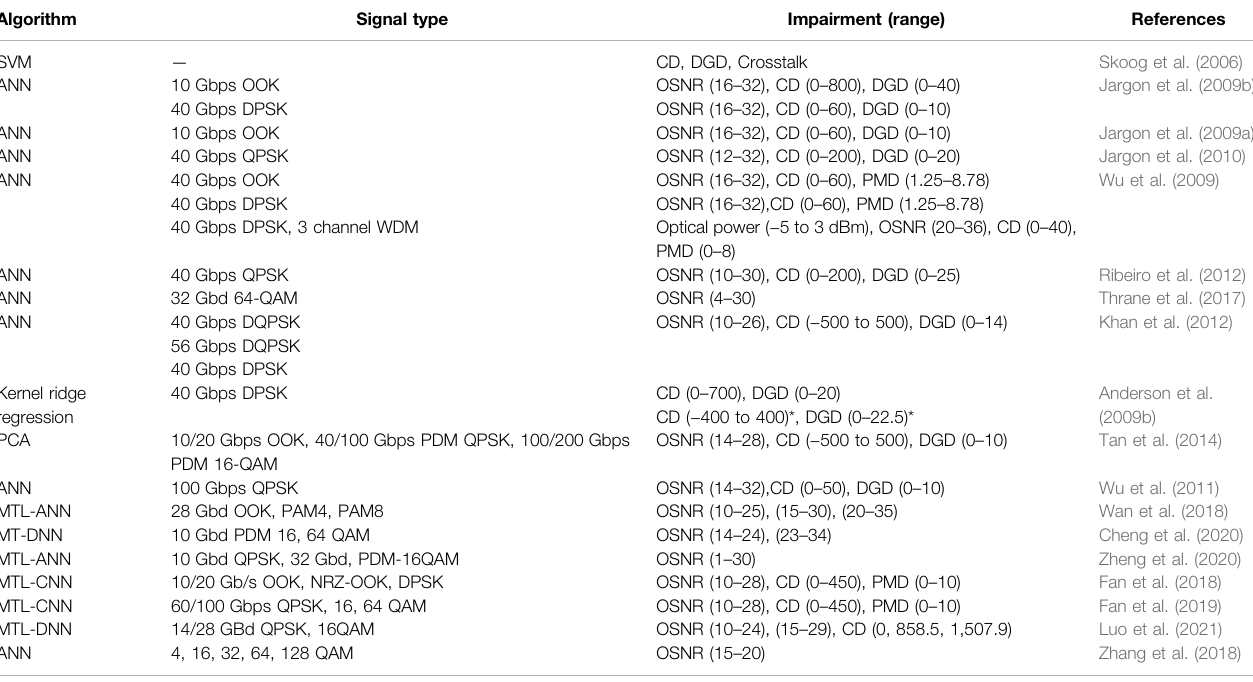
TABLE 2 | Summary of existing OPM works for direct